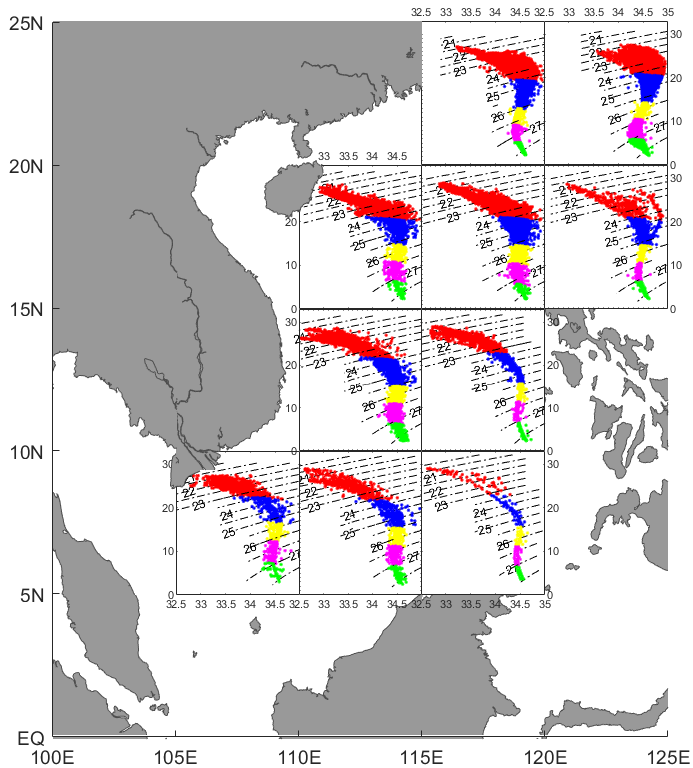
Figure 5. The T-S diagram of sub-regional clustering in winter. Red scatter: the surface water; blue scatter: the subsurface water; yellow scatter: the subsurface–intermediate mixing water; pink scatter: the intermediate water; green scatter: the deep water.